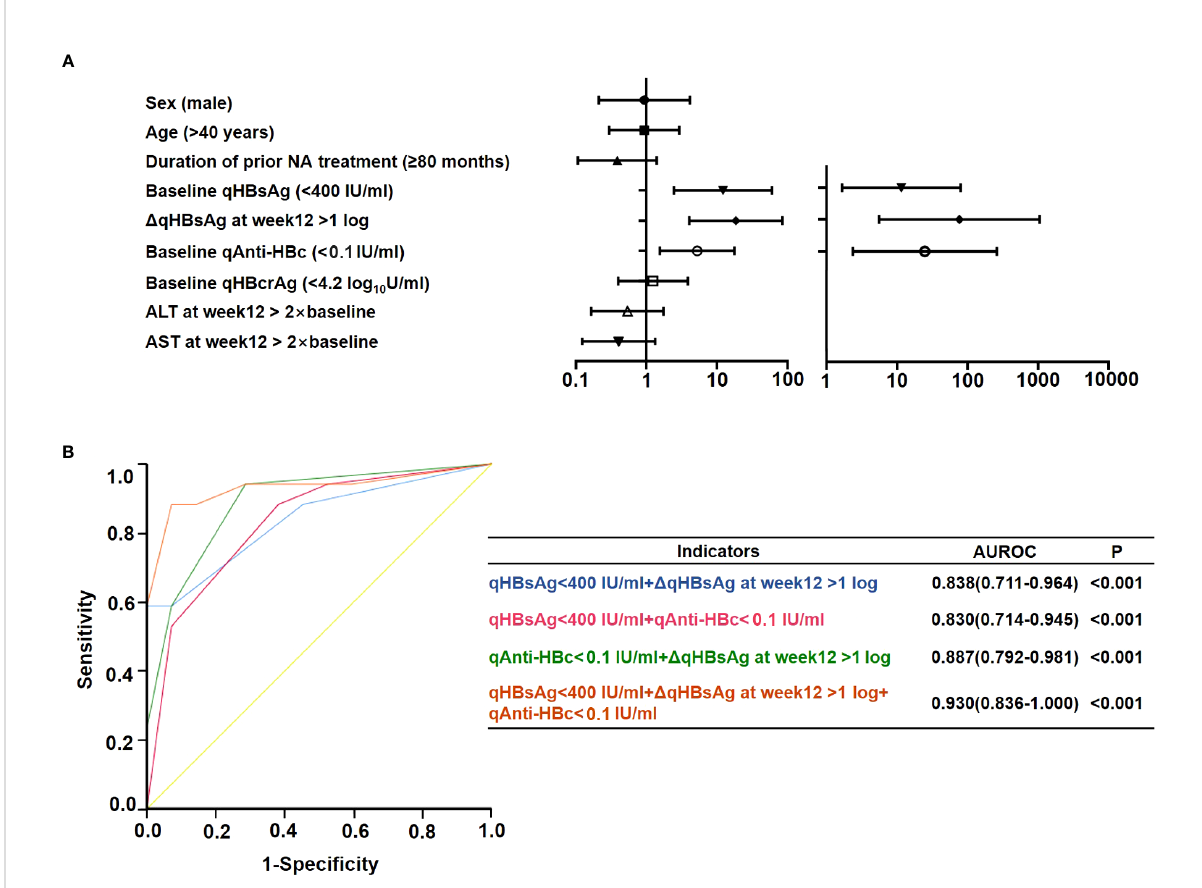
FIGURE 5 Prediction of HBsAg loss at week 48 in the add-on group. (A) Univariate and multivariate logistics regression analysis of factors predicting HBsAg loss at week 48. (B) Receiver operating characteristic curve of factors predicting HBsAg loss at week 48. NA, nucleos(t)ide analogs; ALT, alanine aminotransferase; qAnti-HBc, quantitative anti-hepatitis B core antibody; HBsAg, hepatitis B surface antigen; qHBsAg, quantitative HBsAg; qHBcrAg, quantitative hepatitis B core-related antigen; AUROC, area under the receiver operating characteristic curve; D , decline in